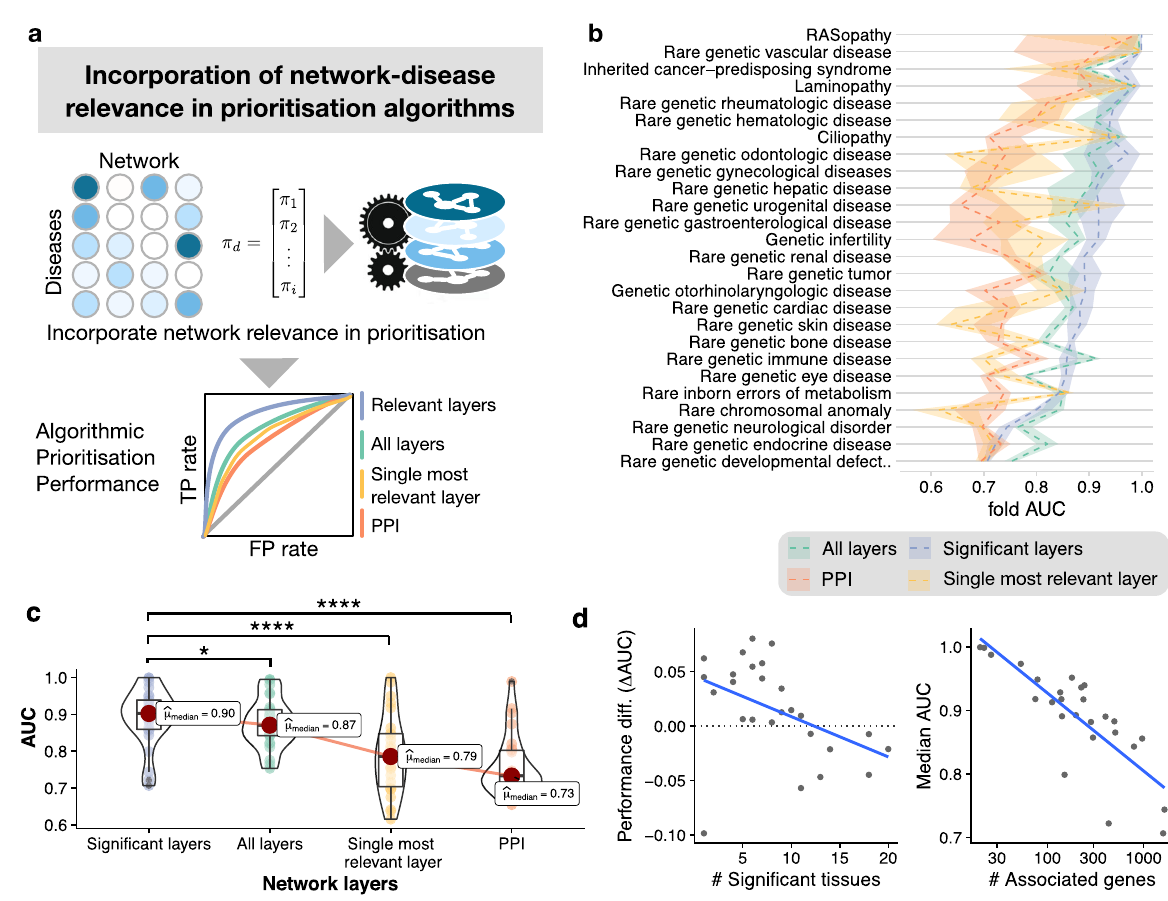
Fig. 5 Using network modularity as relevance prior in the informed propagation algorithm for gene prioritization. a Schematic overview of the informed multiplex network propagation algorithm that incorporates modularity as measure of relevance of a particular network level for a given disease group. b Comparison of 10-fold cross-validation performance in rare disease gene retrieval for different choices of included networks: Informed algorithm with most relevant network (blue), all networks (green), the PPI (red), and the single most relevant layer for each disease (yellow). Dashed lines show median value across all folds, shaded areas represent the interquartile range. The retrieval performance indicates that disease mechanisms are generally better recapitulated by incorporating relevant networks only. c Comparison of the AUROC from all four methods. Utilizing the signi fi cant networks lead to more accurate disease gene retrieval compared to all networks, the single most relevant layer, or the PPI. (Bonferroni-Holm corrected Durbin-Conover test p - value = 0.026, 1.22e − 6, and 3e-16 respectively). Threshold for p -values: p < 0.05:*, p < 0.01:**, p < 0.001:***, p < 0.0001:****; n = 26 rare disease groups across all network sets. Bounds of box represent 25th and 75th percentiles, center the median, whiskers 10th and 90th percentiles, respectively. d Factors correlated with the retrieval performance. The algorithm that incorporates all networks can outperform the informed algorithm for diseases with high levels of syndromicity, i.e., disease that manifest in multiple physiological systems (left, Spearman ’ s ρ = − 0.53, corresponding p -value = 0.004). Decreasing functional relevance as the number of genes increases also led to lower predictive performance (right, Spearman ’ s ρ = − 0.83, p -value = 1.94e-6). The corresponding p -value of correlation was determined by Fisher z-transformation,